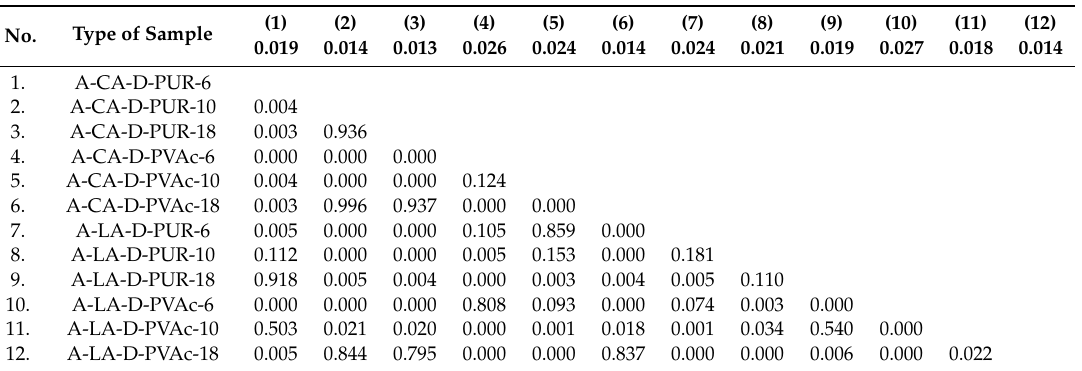
Table 23. Comparison of the e ff ects of individual factors using Duncan’s test on the coe ffi cient of bendability ( K bendB ) for aspen and NWC on the bottom.